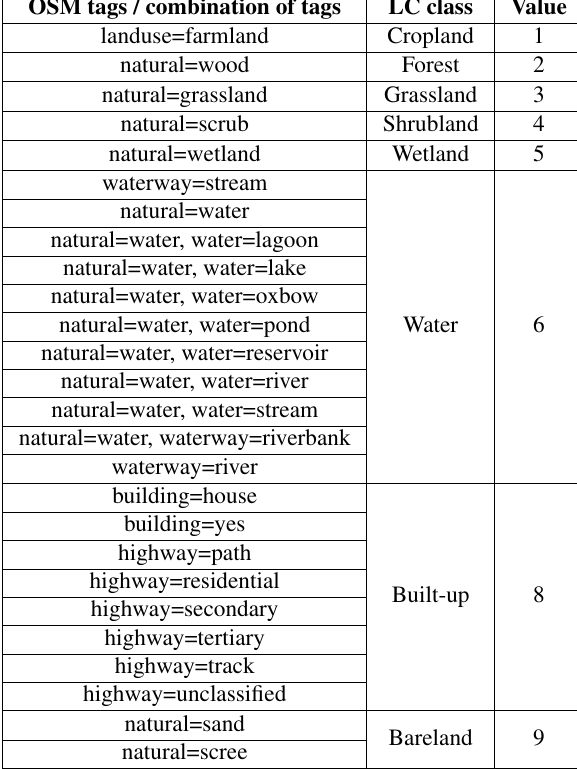
Table 1: OSM tags and their correspondence to the land cover